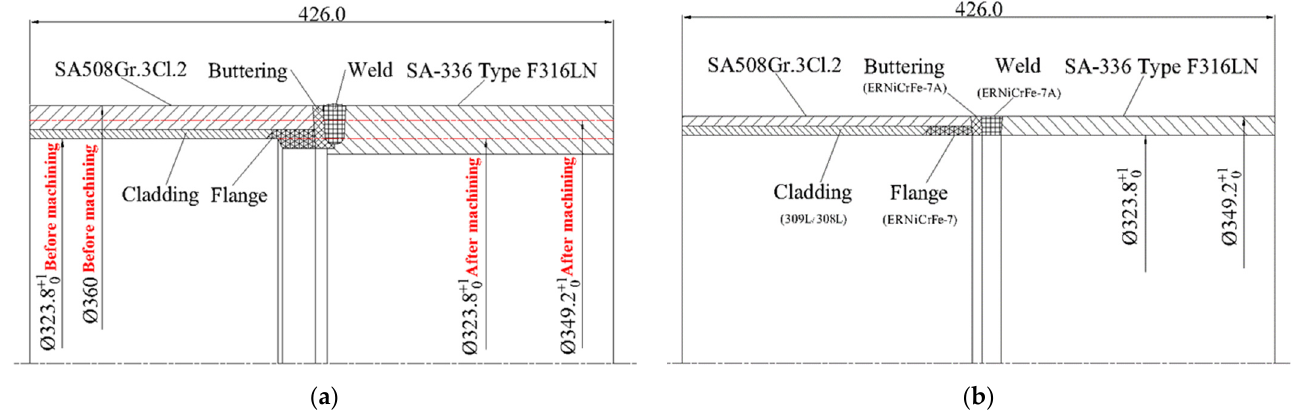
Figure 1. Mock-up design of the nuclear safe-end DMW joint: ( a ) manufacture design of the mock-up with radial dimensions marked before (left) and after machining (left); ( b ) final dimensions of the mock-up after machining (about 426 mm in length).